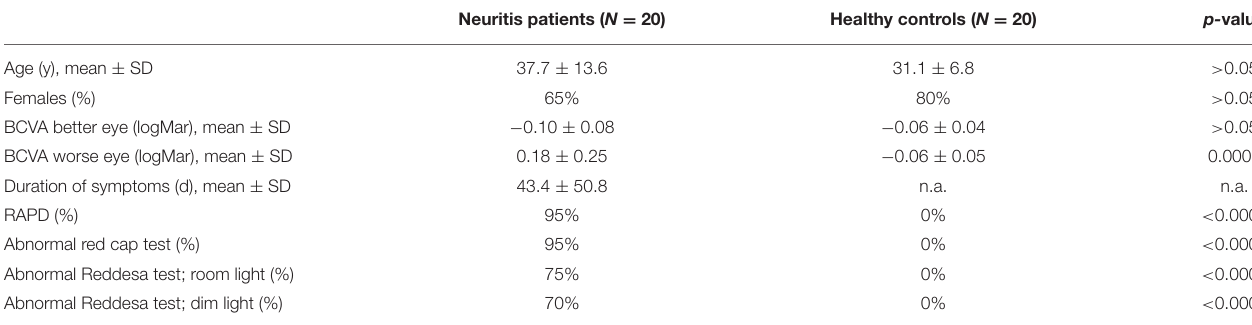
TABLE 2 | Descriptive statistics of patients with optic neuritis and healthy